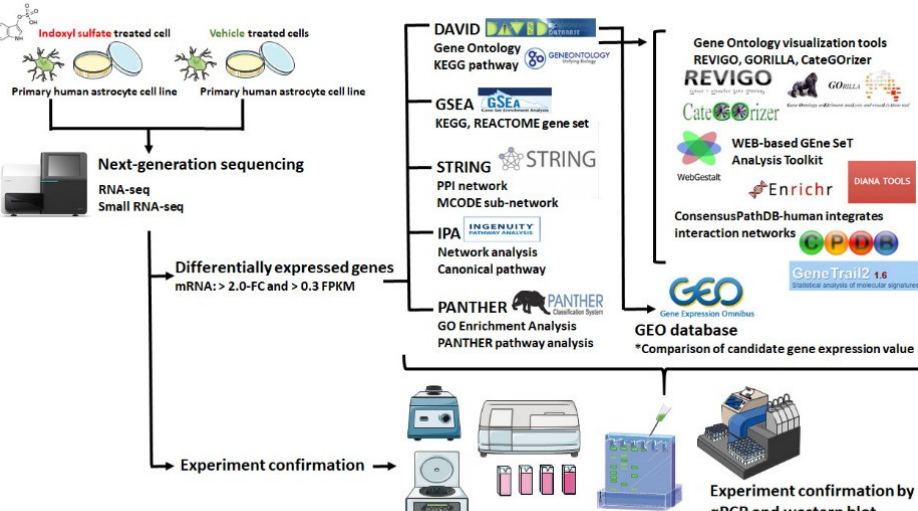
Figure 1. Flowchart of study design. The primary human astrocytes with and without IS treatment were cultured and harvested for RNA sequencing and expression profiling. Differentially expressed genes with >2-fold change (FC) and >0.3 fragments per kilo base of transcript million (FPKM) were selected for further enrichment analyses by using different bioinformatics resources. Array data related to IS-treated cell lines were searched in the Gene Expression Omnibus (GEO) database, and the expression patterns of candidate genes of interest in these arrays were analyzed. The bioinformatics analysis results were further verified by experimental